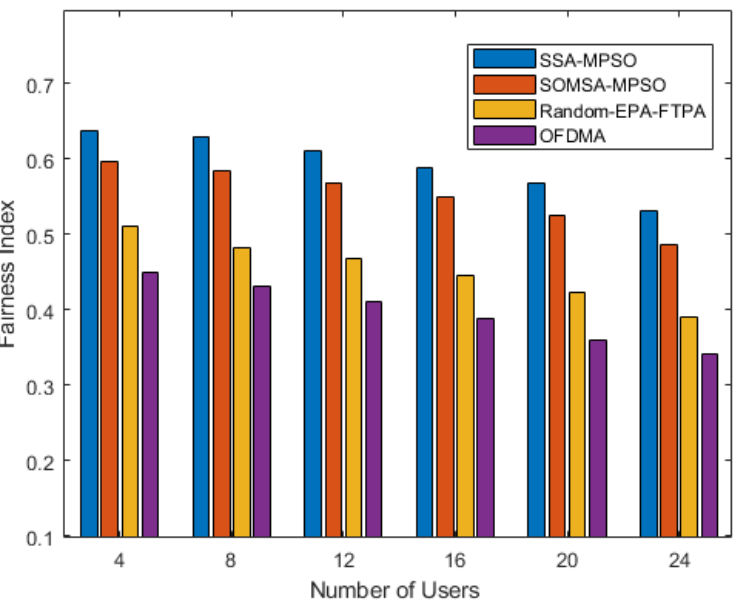
Figure 6. The fairness index versus